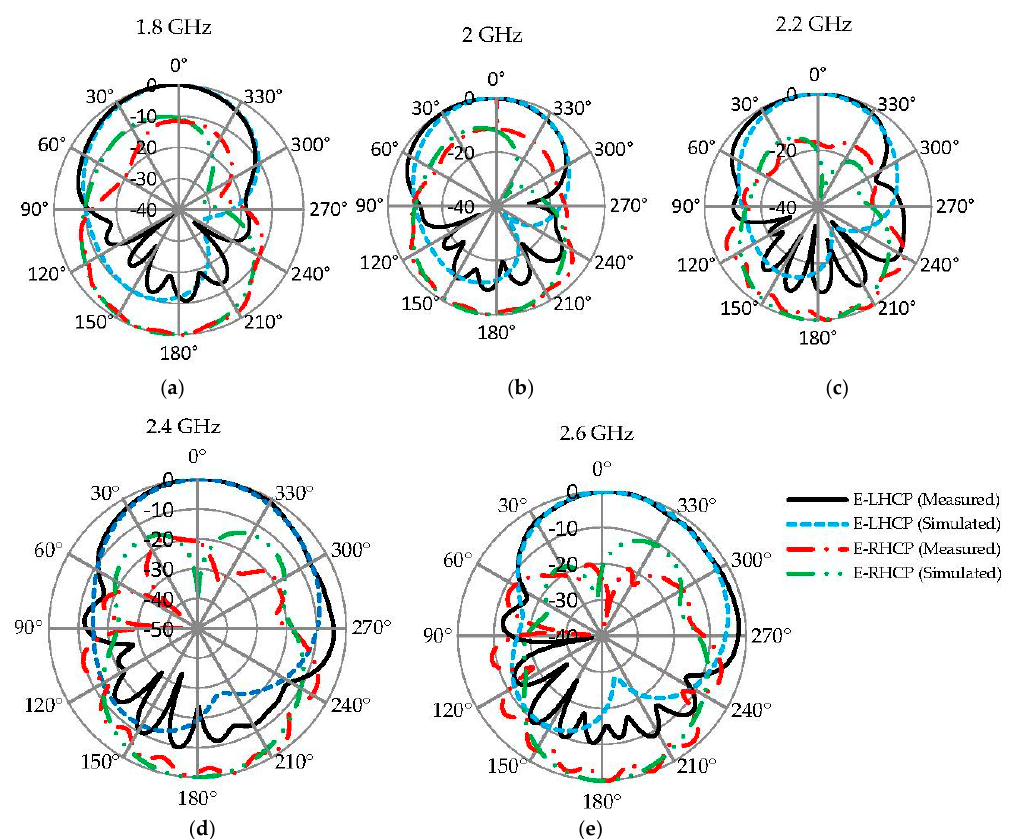
Figure 10. Measured and simulated E-plane radiation patterns of the antenna at ( a ) 1.8 GHz, ( b ) 2 GHz, ( c ) 2.2 GHz, ( d ) 2.4 GHz, and ( e ) 2.6 GHz.